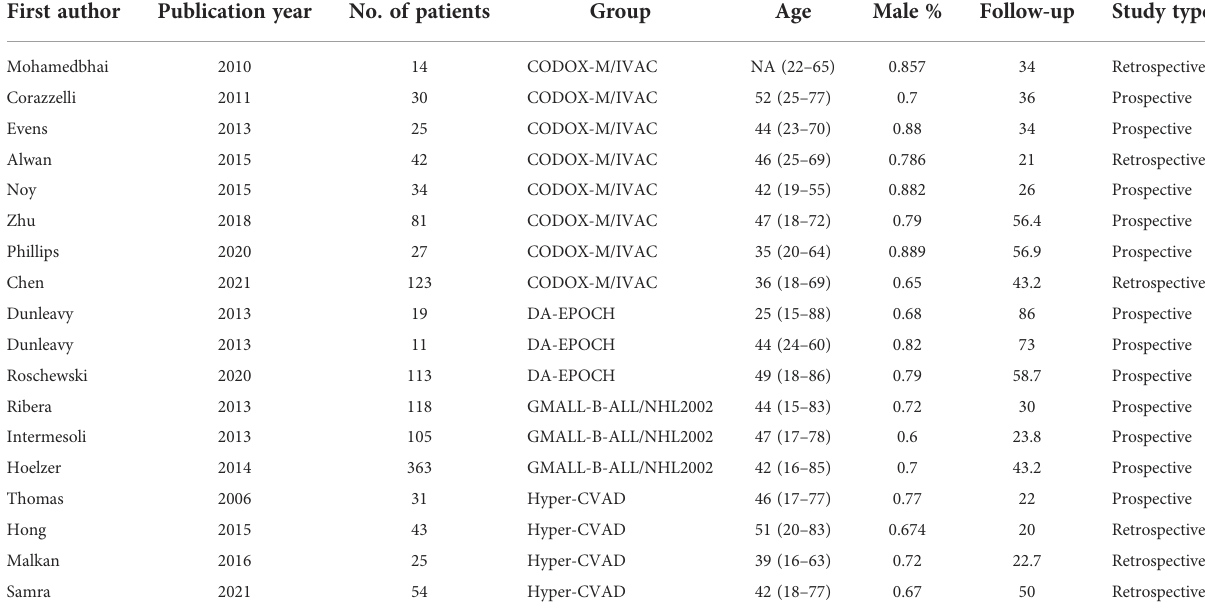
TABLE 1 Baseline characteristics of included